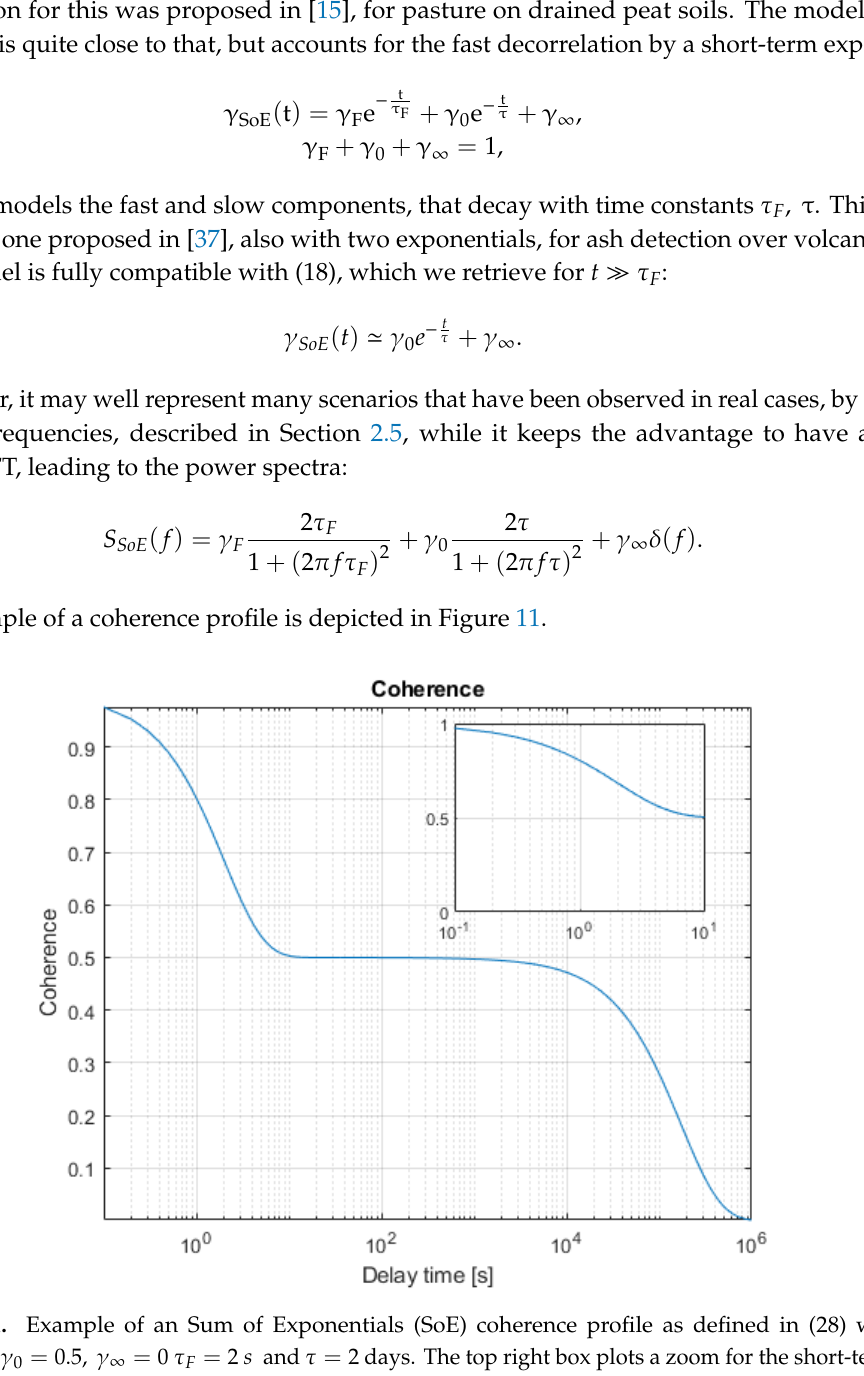
Figure 11. Example of an Sum of Exponentials (SoE) coherence profile as defined in (28) with 𝛾 0.5, 𝛾 = 0.5, 𝛾 = 0 𝜏 = 2 𝑠 and 𝜏 = 2 days. The top right box plots a zoom for the short-term.